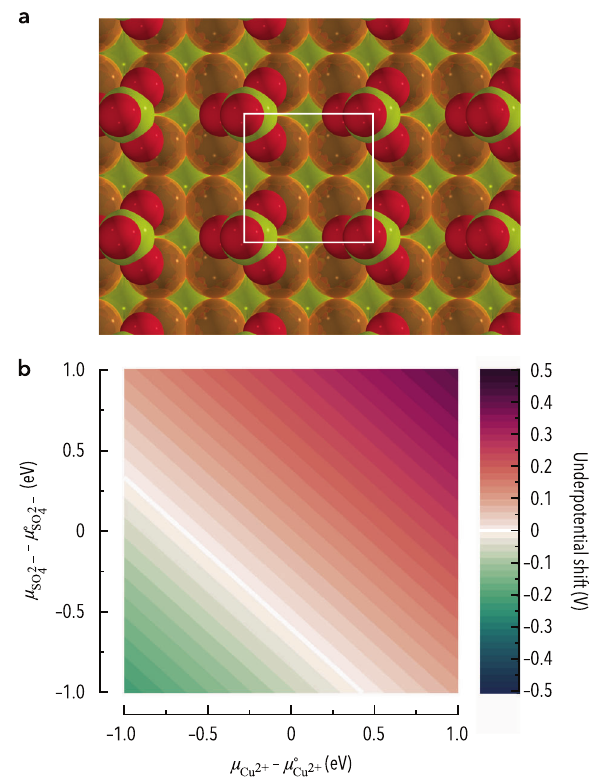
Fig. 4 a The co-adsorbed sulfates are included as a p (2 × 2) overlayer at the fourfold hollow sites of the copper adlayer. b In fl uence of the activities of the hydrated sulfate ion and hydrated copper ion on the underpotential shift at a capacitance of 20 μ F/cm